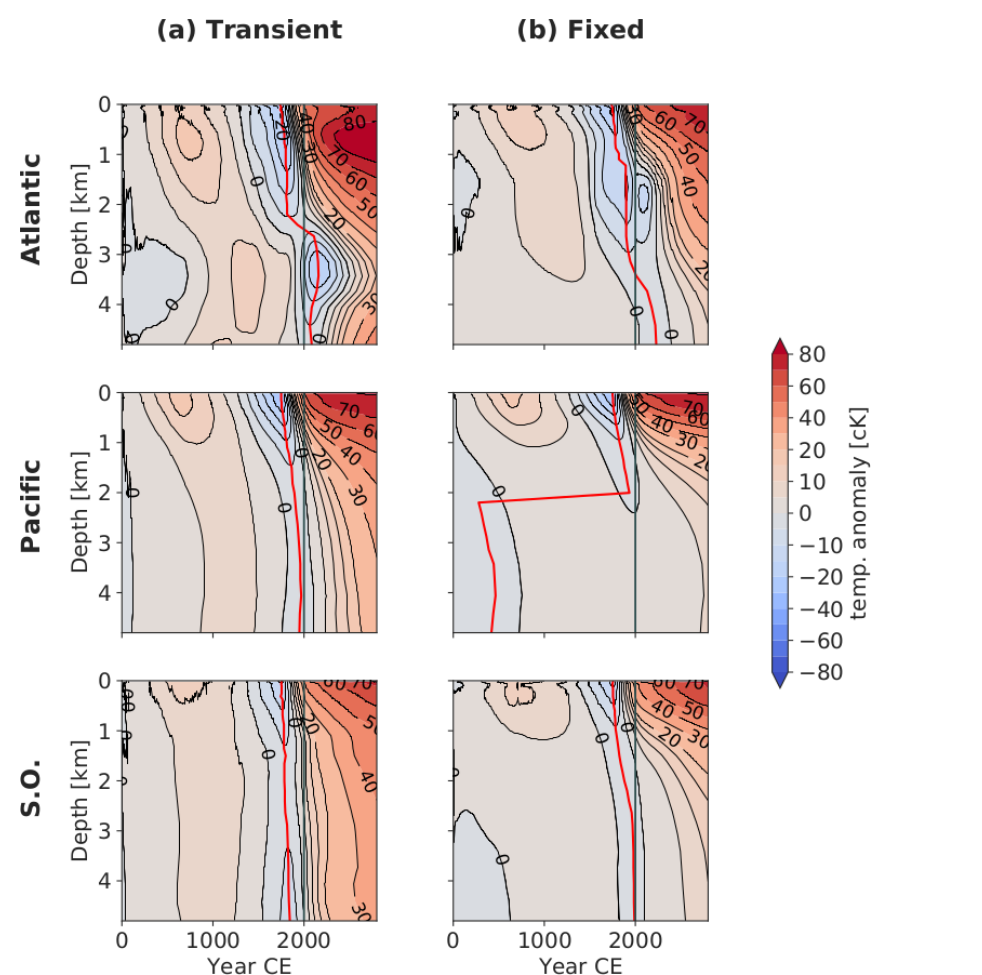
Figure A6. Hovmöller diagrams as in Fig. 4a and b (see caption there) but now for simulations (a) OcTRALong (transient) and (b) Oc- FIXLong (fixed). The minimum temperature anomaly (red line) jumps for the fixed simulation, because no cooling is detected in the Pacific below 2km. Note the extended time axis from 0 to 2800CE, because a medieval warm period (MWP) is now included. For OcTRALong and OcFIXLong, SST, SSS and sea ice boundary conditions are read in from a coupled simulation OcAtmTRALong starting at 0CE with a MWP. For consistency with the later simple evolution, the MWP radiative forcing from 0 to 1200CE is chosen to be triangular-shaped with a maximum of 0.35Wm − 2 at 600CE (resulting in an SST amplitude comparable to Gebbie and Huybers, 2019). From 1200CE the forcing is identical to the forcing in Fig.